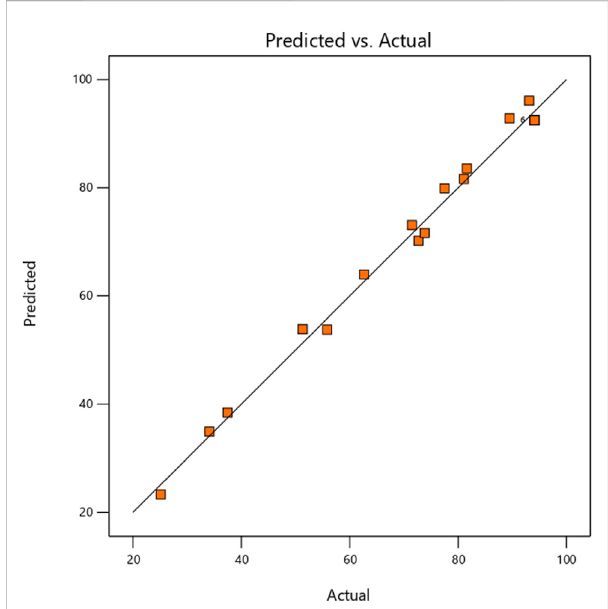
FIGURE 4 Comparison plot showing experimental (actual) and predictive values for J. curcas Seed Biolubricant synthesis.